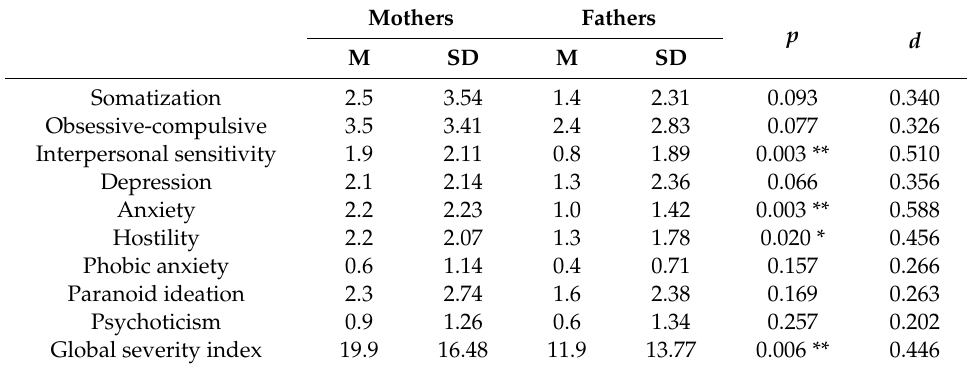
Table 3. Comparison of mental health between mothers and fathers of children and adolescents with rare diseases currently or potentially prospectively requiring mechanical long-term ventilation.